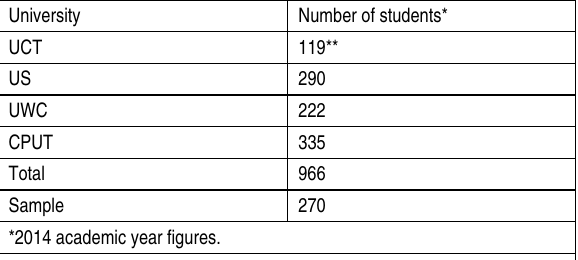
Table 2. Population and